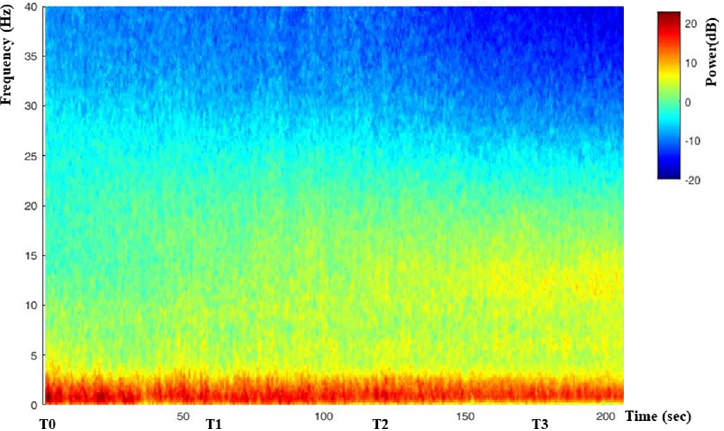
Fig 3. Group-median spectrogram during T0–T3. Group-median spectrograms show that the power of alpha waves (8–13 Hz) and beta waves (13–30 Hz) became stronger and weaker, respectively, with time. https://doi.org/10.1371/journal.pone.0257467.g003 and 57.1 ± 8.1, respectively, however, no significant differences were observed between the two groups (P > 0.05). PLE decreased significantly compared to TR0 in group R (P < 0.05) at TR2, TR3, and TR4. However, no significant differences were observed in PLE or EMG_PLE between the two groups at any time point (P > 0.05) (Table 4). Mean blood pressure and heart rate did not change significantly at any time point compared to TR0 in either group, and no significant differences were observed between the two groups (S1 Table).